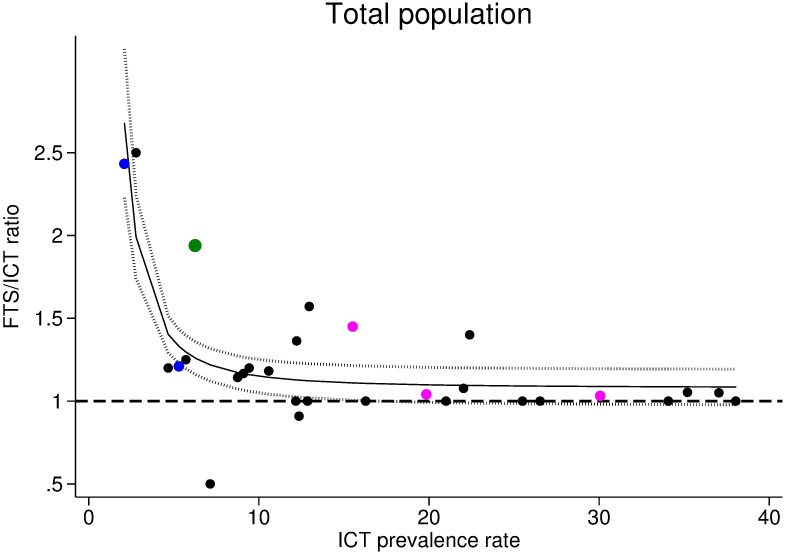
Relationship between the ICT prevalence rate and the FTS/ICT ratio.All the data were included in this figure: Liberia (Foya and Harper), Côte d'Ivoire (Soribadougou and Yadio), Congo, DRC, Sri Lanka, and Indonesia (see Table 1 for details). Foya and Harper study areas comprised 9 and 15 villages, respectively. Black symbols (post-MDA IVM+ALB), blue symbols (post-MDA DEC+ALB), green symbol (post-MDA ALB alone), and pink symbols (pre-MDA).